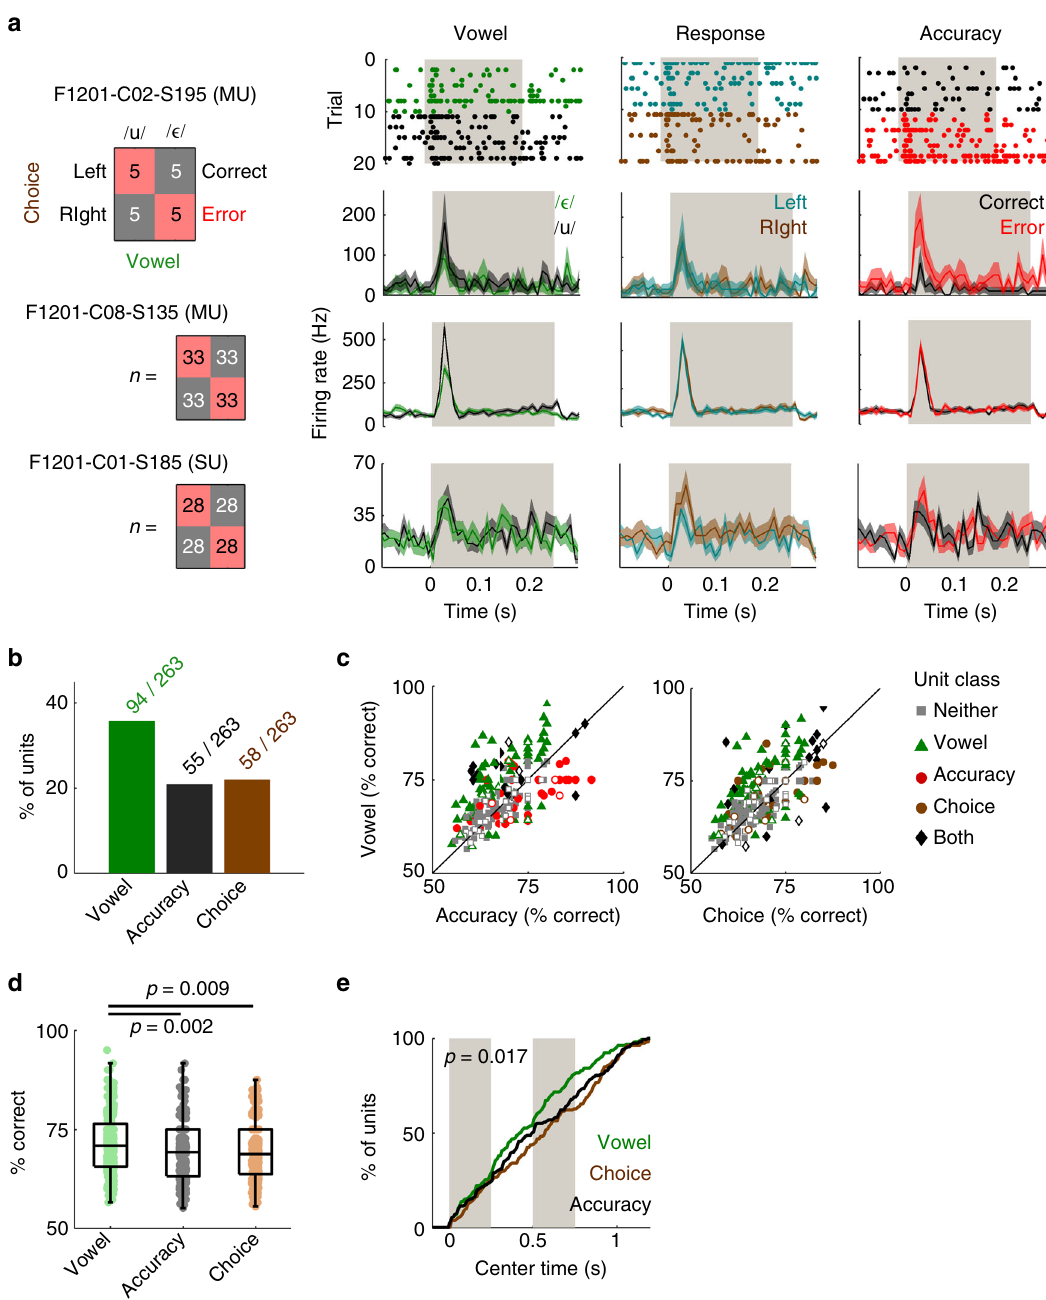
Fig. 4 Auditory cortical neurons encode sound, choice and accuracy. a Analysis design for matching equal numbers of responses to each vowel (/u/: black; / ε /: green), behavioral choice (left: cyan; right: brown) and trial outcome (correct: black; error: red). Data shown as raster plots of spike times on each trial for one unit and PSTHs representing mean ± s.e.m. fi ring rate across trials for three units (two multi-units [MU] and one single unit [SU]). Gray bars show the fi rst stimulus token. Trial contingency (i.e., respond left for / ε /) shown as an example on which one ferret was trained (F1217). b Percentage of units informative about sound, choice and/or accuracy in matched data. c Performance decoding sound, choice, and accuracy across all units. Markers show individual units labeled by classi fi cation as informative about vowel only (green triangles), accuracy only (red circles), choice only (brown circles), no variable (neither: gray squares) or multiple variables (both: black diamonds). The terms neither and both refer to the dimensions shown within each scatter plot (e.g., about both vowel and choice) rather than across plots. Single/multi-unit data shown by un fi lled/ fi lled markers. d Comparison of performance decoding sound, choice and accuracy; boxplots show median, interquartile range (box) and 99.3% intervals (whiskers). Values ( p ) show signi fi cant Tukey – Kramer corrected pairwise comparisons following Kruskal – Wallis test. e Cumulative distributions showing center times for best performance when decoding vowel (green), choice (brown) and accuracy (black). Gray bars represent the duration of the each token within the stimulus. Data shown for all units that were informative about one or more variables. Value ( p ) shows signi fi cant difference in time of decoding identity, choice and accuracy (Kruskal – Wallis